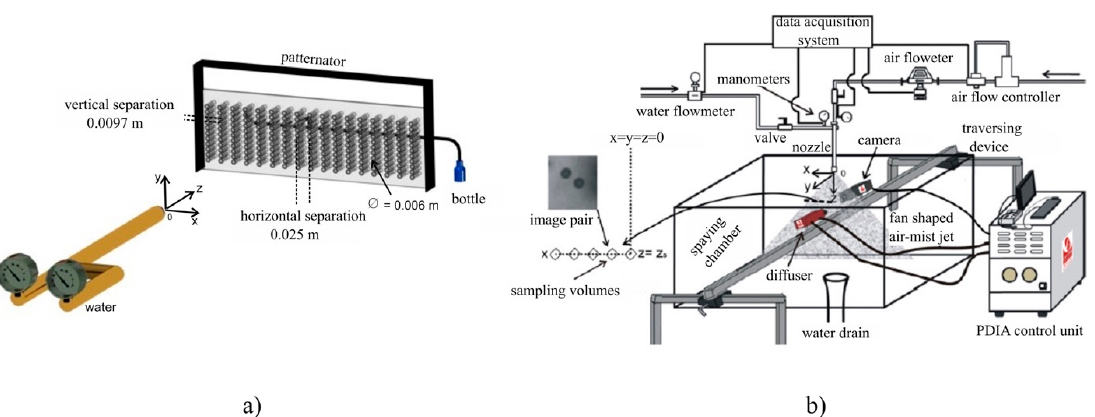
Figure 2. Schematics of experimental apparatuses: ( a ) patternator and ( b ) particle droplet image analyzer.